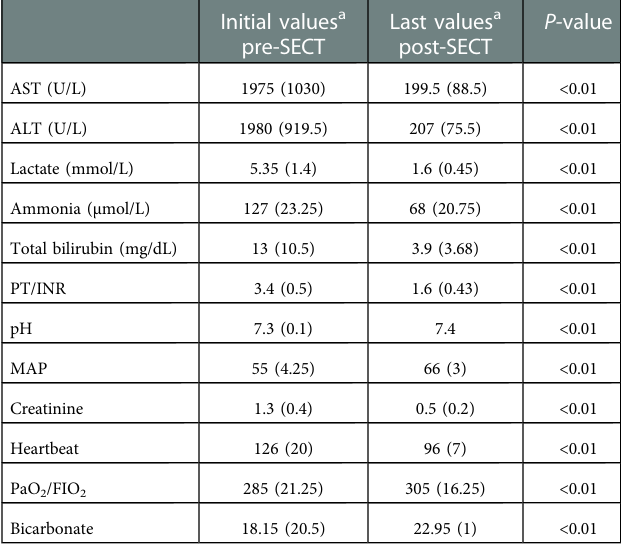
TABLE 3 Laboratory values of all patients at admission and after treatment.